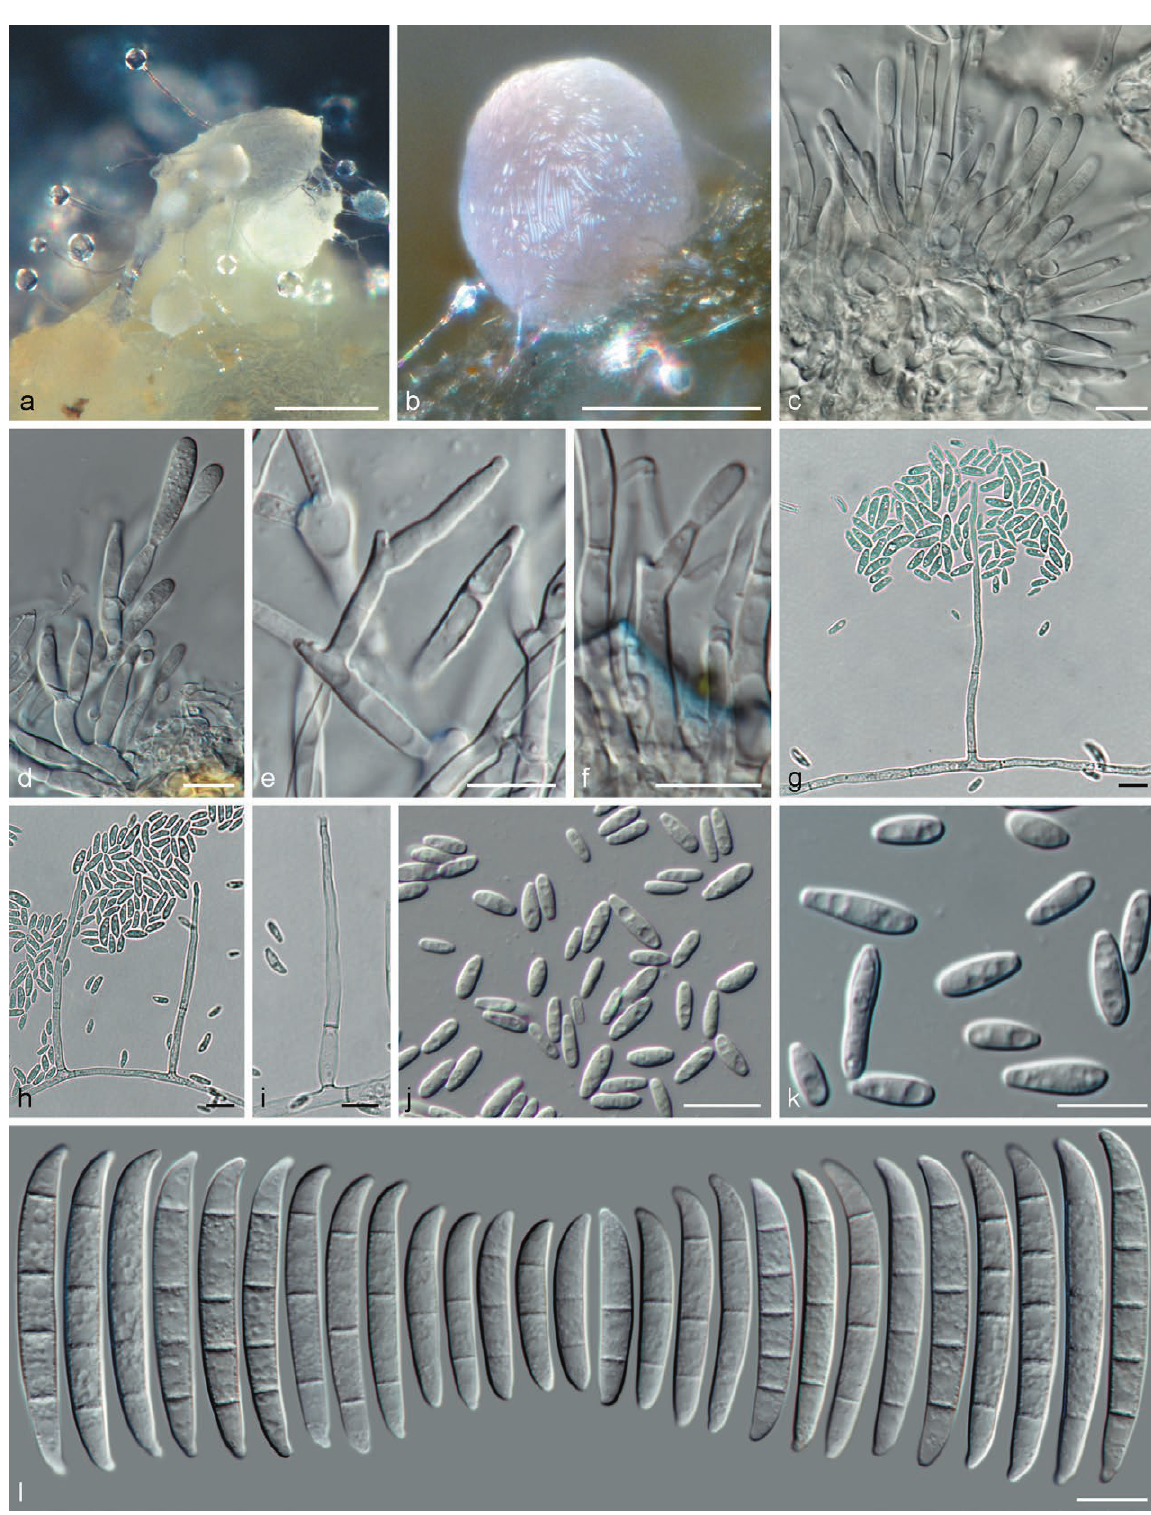
Figure 4. Neocosmospora addoensis (ex-type culture CBS 146510). (a and b) sporodochia formed on the surface of carnation leaves; (c to f) sporodochial conidiophores and phialides; (g to i) aerial conidiophores; (j and k. aerial conidia; (l) sporodochial conidia. Scale bars: a and b = 100 μm; c to l = 10